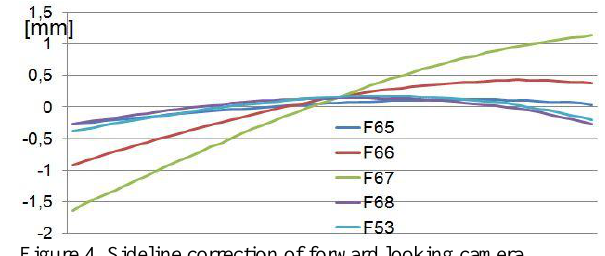
Figure 4. Sideline correction of forward looking camera